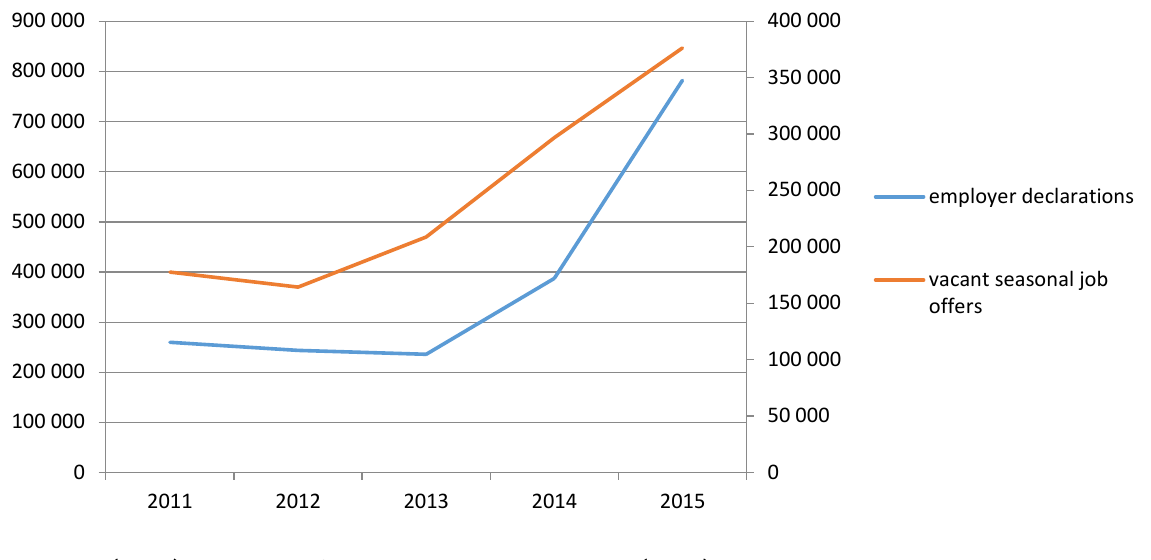
Source: CSO (2017a) and Ministry of Family, Labour and Social Policy